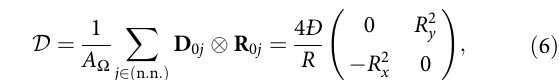
Fig. 2c ( blue arrows ). The spiralization tensor for 2D systems 24 takes then the form